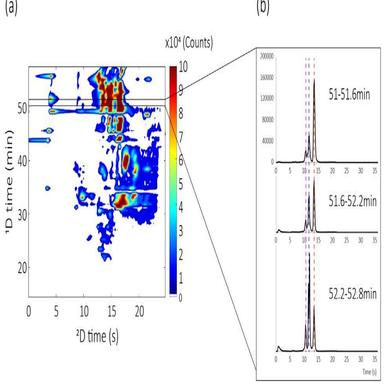
(a) On-line RPLC x SFC separation of the full bio-oil sample: contour plot representing the sum of 44 EICs (b) 2D separation of three successive fractions. Analytical conditions in 1.